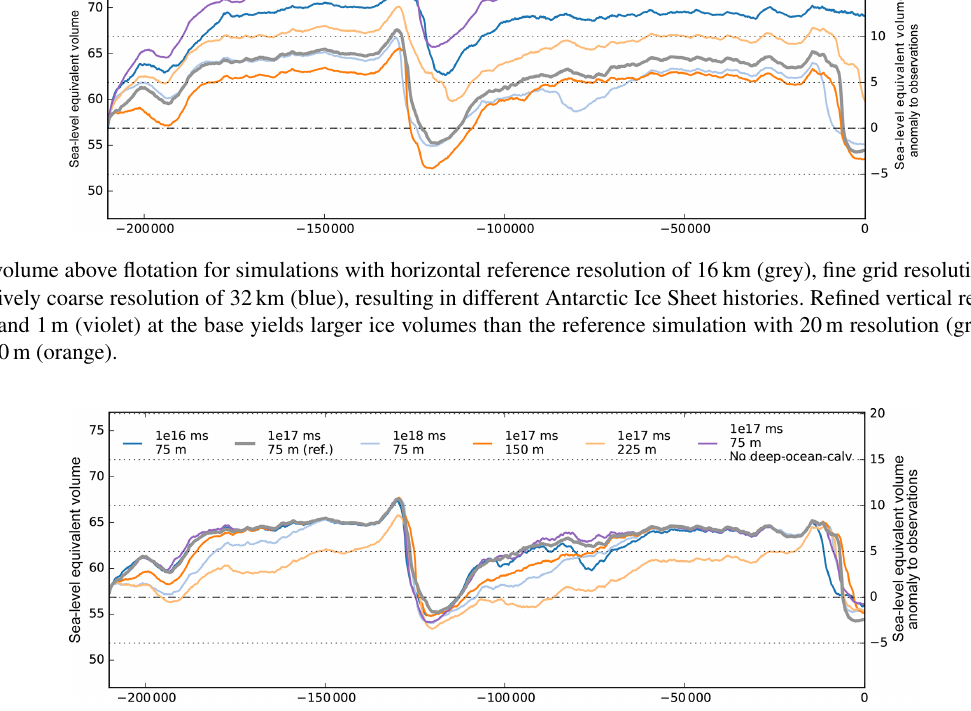
Figure 6. Ice volume histories over two glacial cycles for different parameter values of eigencalving constant (blue and light blue) and calving thickness (orange and light orange) compared to the reference simulation (grey). Defining a maximum extent of the ice along the edge of the continental shelf (“deep-ocean-calv”) has only negligible effect on the sea-level-relevant ice volume